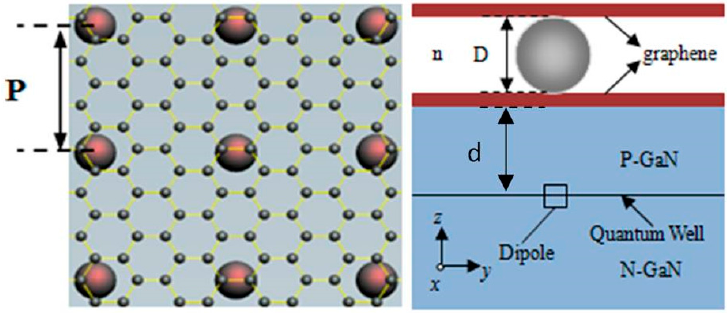
Figure 1. The structure schematic diagrams of graphene-Ag-graphene(GAG).